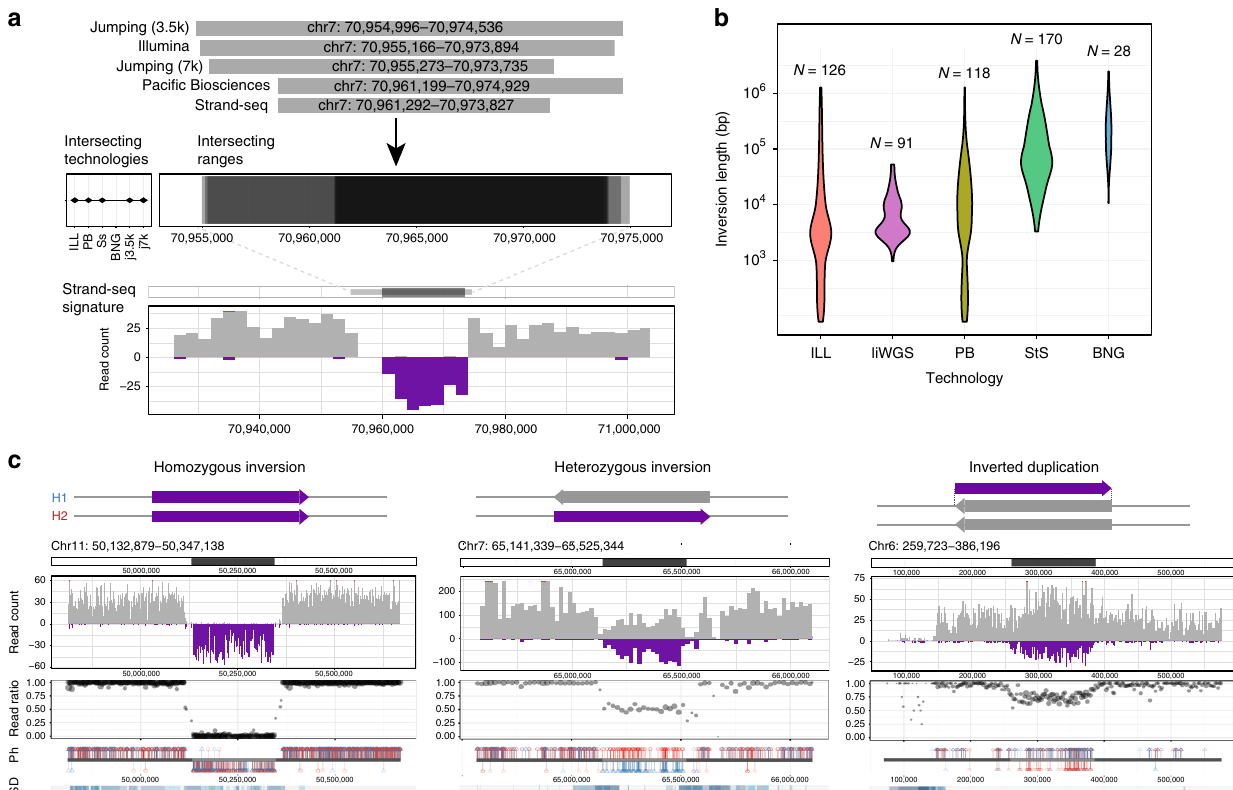
Fig. 3 Characterization of simple and complex inversions. a Integration of inversions across platforms based on reciprocal overlap. Shown is an example of fi ve orthogonal platforms intersecting at a homozygous inversion, with breakpoint ranges and supporting Strand-seq signature illustrated in bottom panels. b Size distribution of inversions included in the uni fi ed inversion list, subdivided by technology, with the total inversions (N) contributed by each listed. c Classi fi cation of Strand-seq inversions based on orthogonal phase support. Illustrative examples of simple (homozygous and heterozygous) and complex (inverted duplication) events are shown. Strand-seq inversions were identi fi ed based on read directionality (read count; reference reads in gray, inverted reads in purple), the relative ratio of reference to inverted reads within the locus (read ratio), and the haplotype structure of the inversion, with phased read data considered in terms of directionality (Ph; H1 alleles in red, H2 alleles in blue; alleles from reference reads are displayed above the ideogram and alleles from inverted reads are displayed below). ILL Illumina. liWGS long-insert whole-genome sequencing libraries. PB Paci fi c Biosciences. StS Strand-seq.